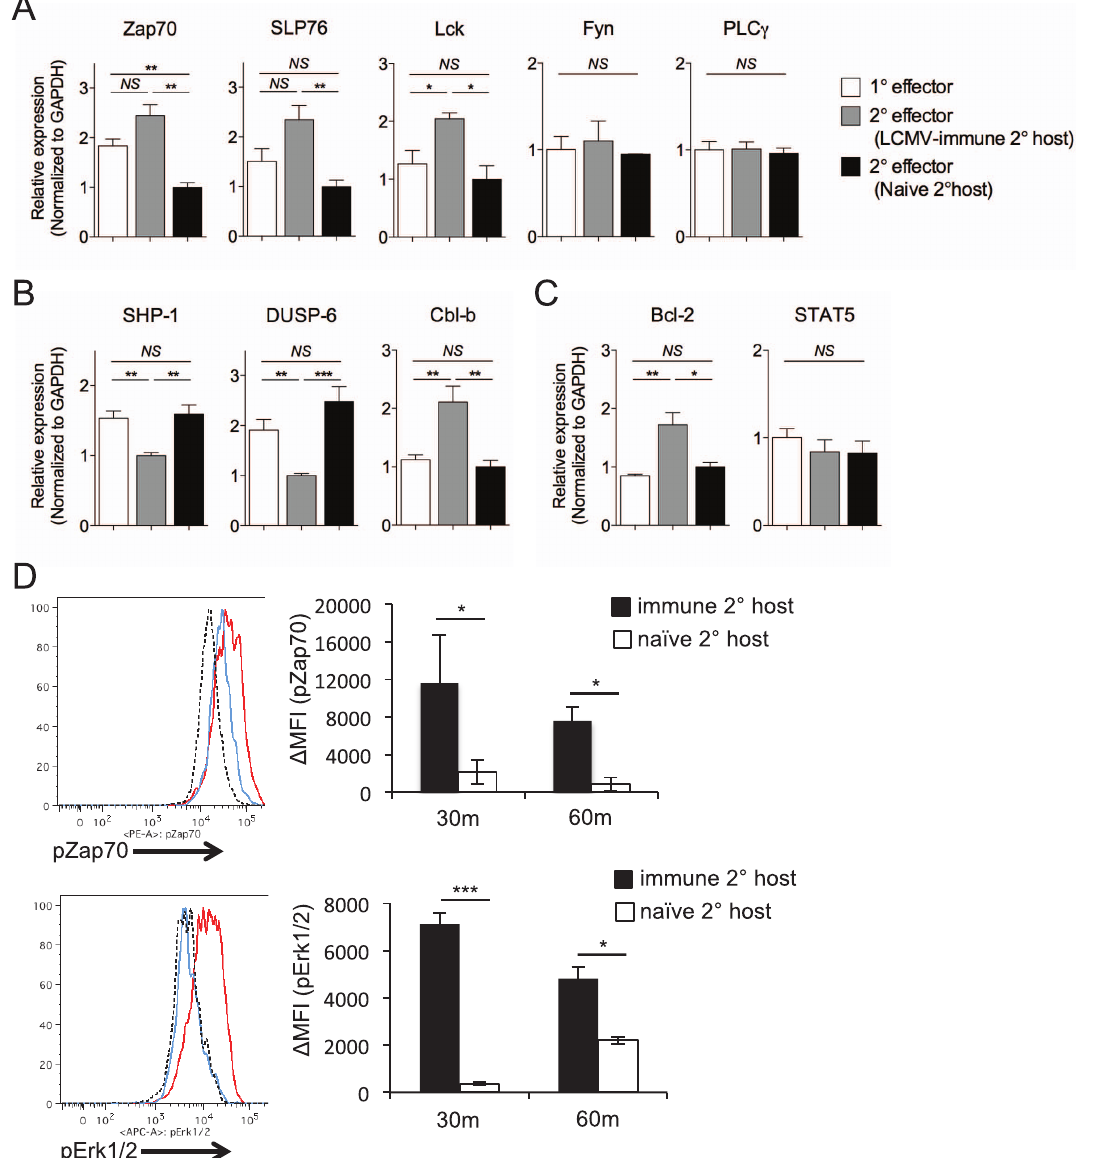
Figure 6. Maintenance of high functional avidity after secondary challenge is associated with enhanced expression of TCR signaling molecules. The relative gene expression of A ) Zap70, SLP76, Lck, Fyn, and PLC c ; B ) SHP-1, DUSP-6, Cbl-b; and C ) Bcl-2 and STAT5 were evaluated by quantitative RT-PCR of FACS-sorted Thy1.1 + secondary SMARTA effector cells in the spleen 7 days after Lm-gp61 challenge of LCMV- immune or naı¨ve secondary hosts, or of primary SMARTA effector cells 8 days after LCMV infection. Results were normalized to GAPDH. D ) Representative flow plots indicate pZap70 and pErk1/2 expression by SMARTA cells after 30 minutes of in vitro peptide restimulation. Histograms indicate secondary SMARTA effector cells (day 7) after Lm-gp61 rechallenge in naı¨ve (blue) or LCMV-immune (red) secondary hosts, as compared to unstimulated controls (dashed). Bar graphs indicate the change in mean fluorescence intensity (MFI) following 30 or 60 minutes of peptide restimulation. Error bars indicate the SEM (n=4 mice/group). Results are representative of two separate experiments. * p , .05; ** p , .01; *** p , .001; NS =not significant, as determined by student’s t-test.